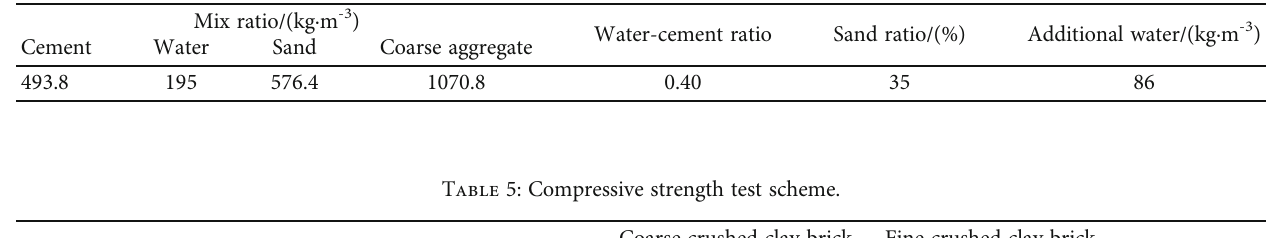
Table 4: Standard mix ratio.